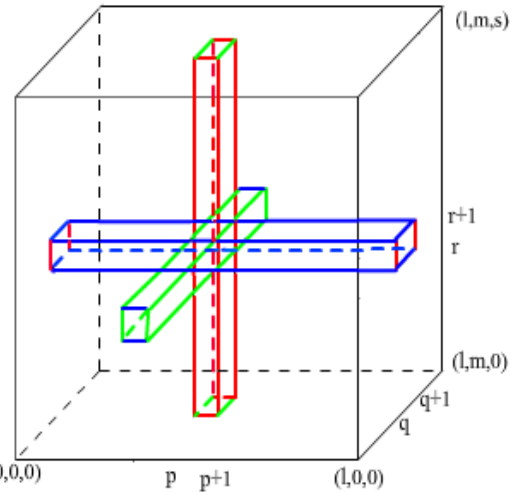
Figure 3. The computation of the interfaces I , II , III